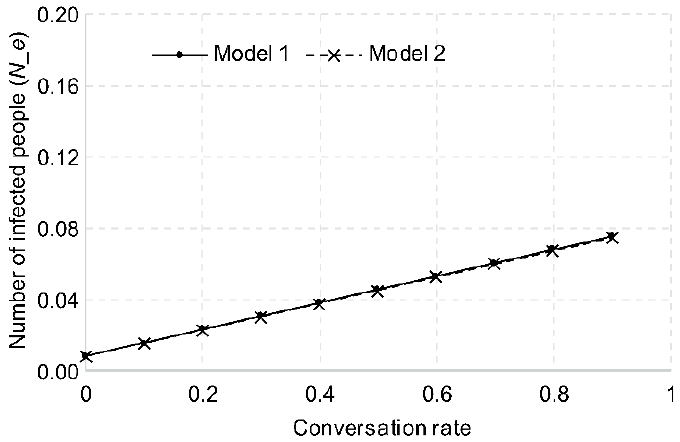
Figure 6. Changes in number of new infections based on conversation rate.